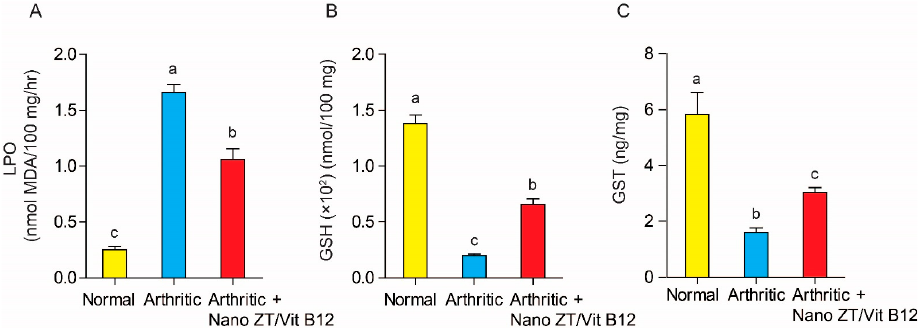
Figure 10. Effect of Nano ZT/Vit B12 on hepatic LPO ( A ) and GSH content ( B ) as well as GST activity ( C ). Data are presented as mean ± SEM; the values for each parameter indicated with a different superscript alphabet (s) (a, b, and c) are significantly different ( p < 0.05). 3.7. Effects of Nano ZT/Vit B12 on TGF- β mRNA Expression and MMP13 Protein Levels TGF- β mRNA expression was significantly ( p < 0.05) higher in arthritic rats than in the control group, as shown in Figure 11. TGF expression, on the other hand, was signifi- cantly ( p < 0.05) reduced in the Nano ZT/Vit B12-treated group. Similarly, when rats were given CFA, the protein level of MMP-13 increased significantly ( p < 0.05) when compared to normal control rats. Nonetheless, MMP-13 protein levels in arthritic rats were signifi- cantly reduced ( p < 0.05) after treatment with Nano ZT/Vit B12.